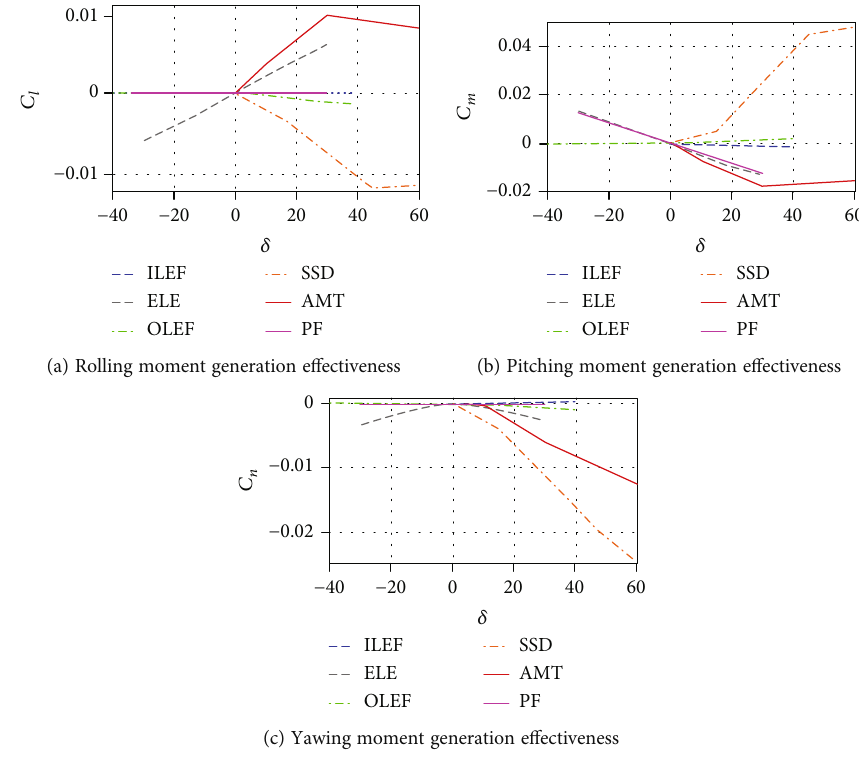
Figure 2: Control e ff ectiveness curve of control surfaces.